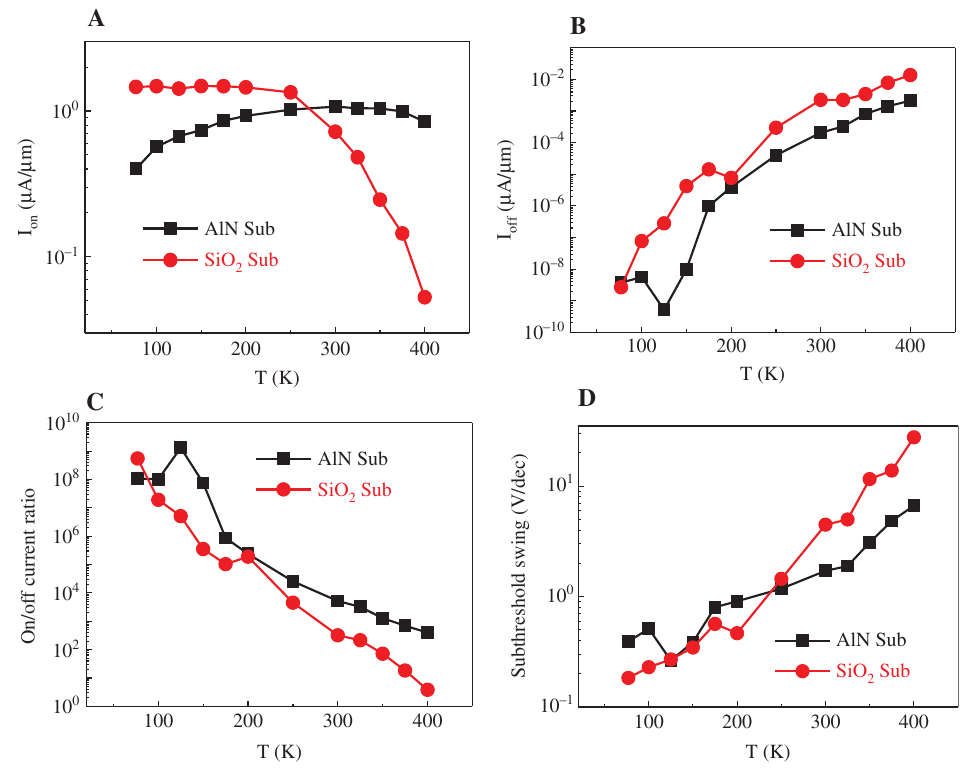
Figure 3: The device parameters for BP FETs as a function of temperature. Temperature evolution of (A) on currents, (B) off currents, (C) on-off current ratio, and (D) subthreshold swing of BP FETs on different substrates extracted from I - V d g